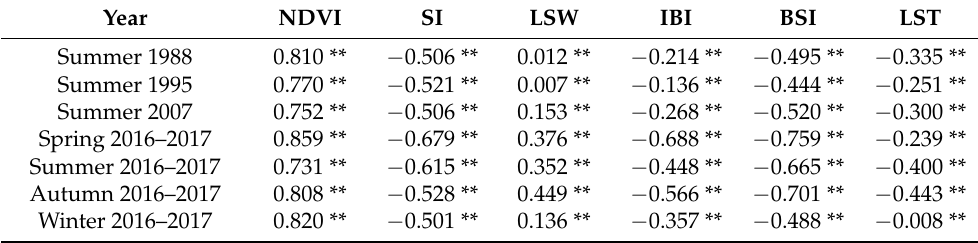
Table 4. Correlation coefficients of NPP with NDVI, SI, LSW, IBI, BSI, and LST.